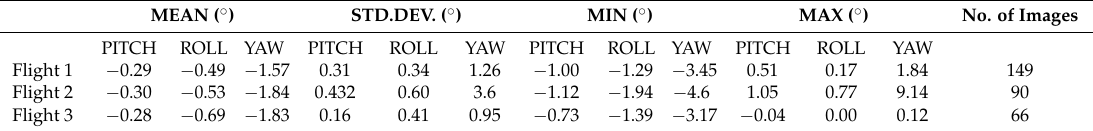
Table 3. The statistics of the differences between the SfM-computed angles and those from the GPS/INS.